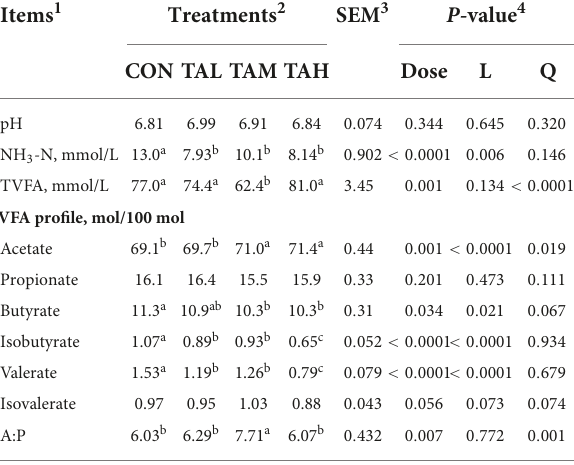
TABLE 3 Effects of tannic acid at different supplemental levels on rumen fermentation characteristics of Holstein